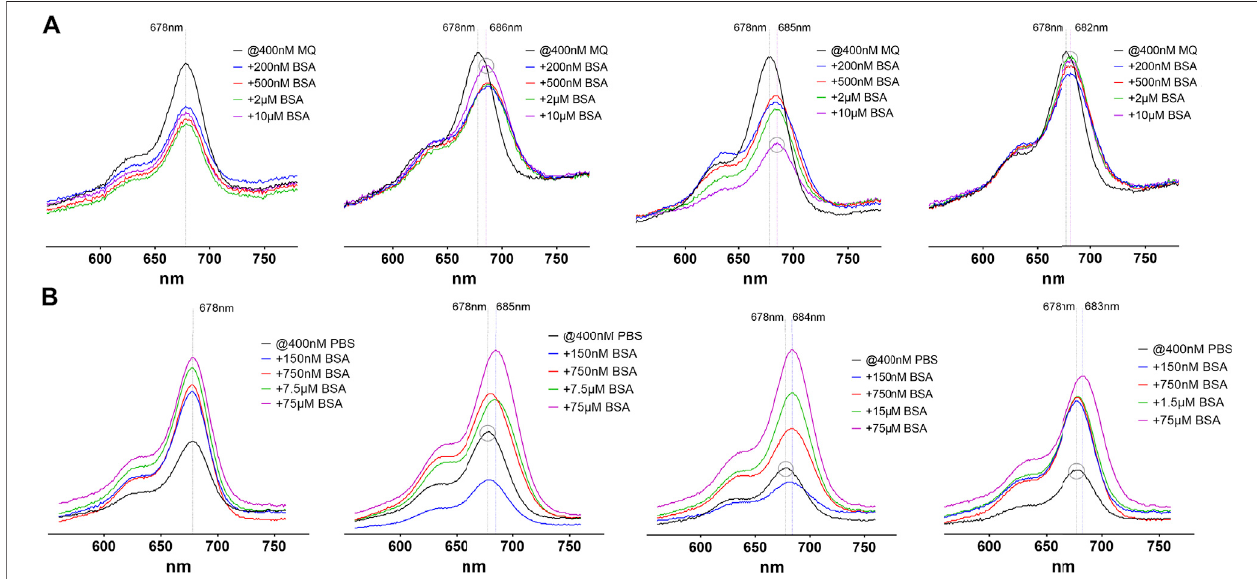
FIGURE 3 | Absorption spectra of the four investigated probes 2 – 5 (from left to right) in pure water (A) and PBS (B) . In each image the black line represents the absorption without addition of BSA, where every compound shows a maximum absorption at 678 nm, regardless of the solvent used. The y-axis scale is identical in all images.Thedashedlines depicttheabsorptionmaximumwavelengthswithoutandwithBSA(maximumred-shift).Thegreycirclestressespeakswiththehighest (A) or lowest (B) absorption maximum wavelength to illustrate the observed red-shifts.